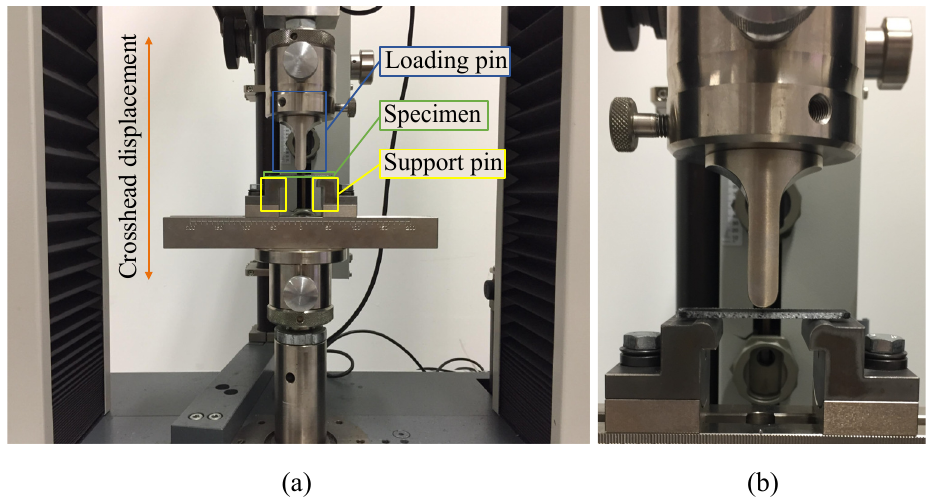
Figure 4. Set up of the three-point bending test according to ISO 14125:1998. In ( a ) the set-up of the three-point bending test is shown including the loading and support pins and the bending test specimen. ( b ) shows a close up of the inserted CF/PA6 specimen before